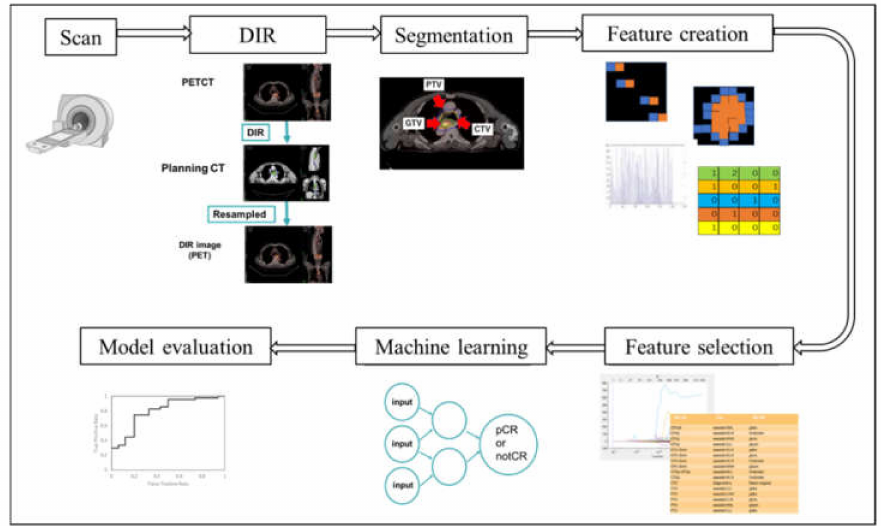
Figure 1. The process of the radiomics analysis and generating prediction